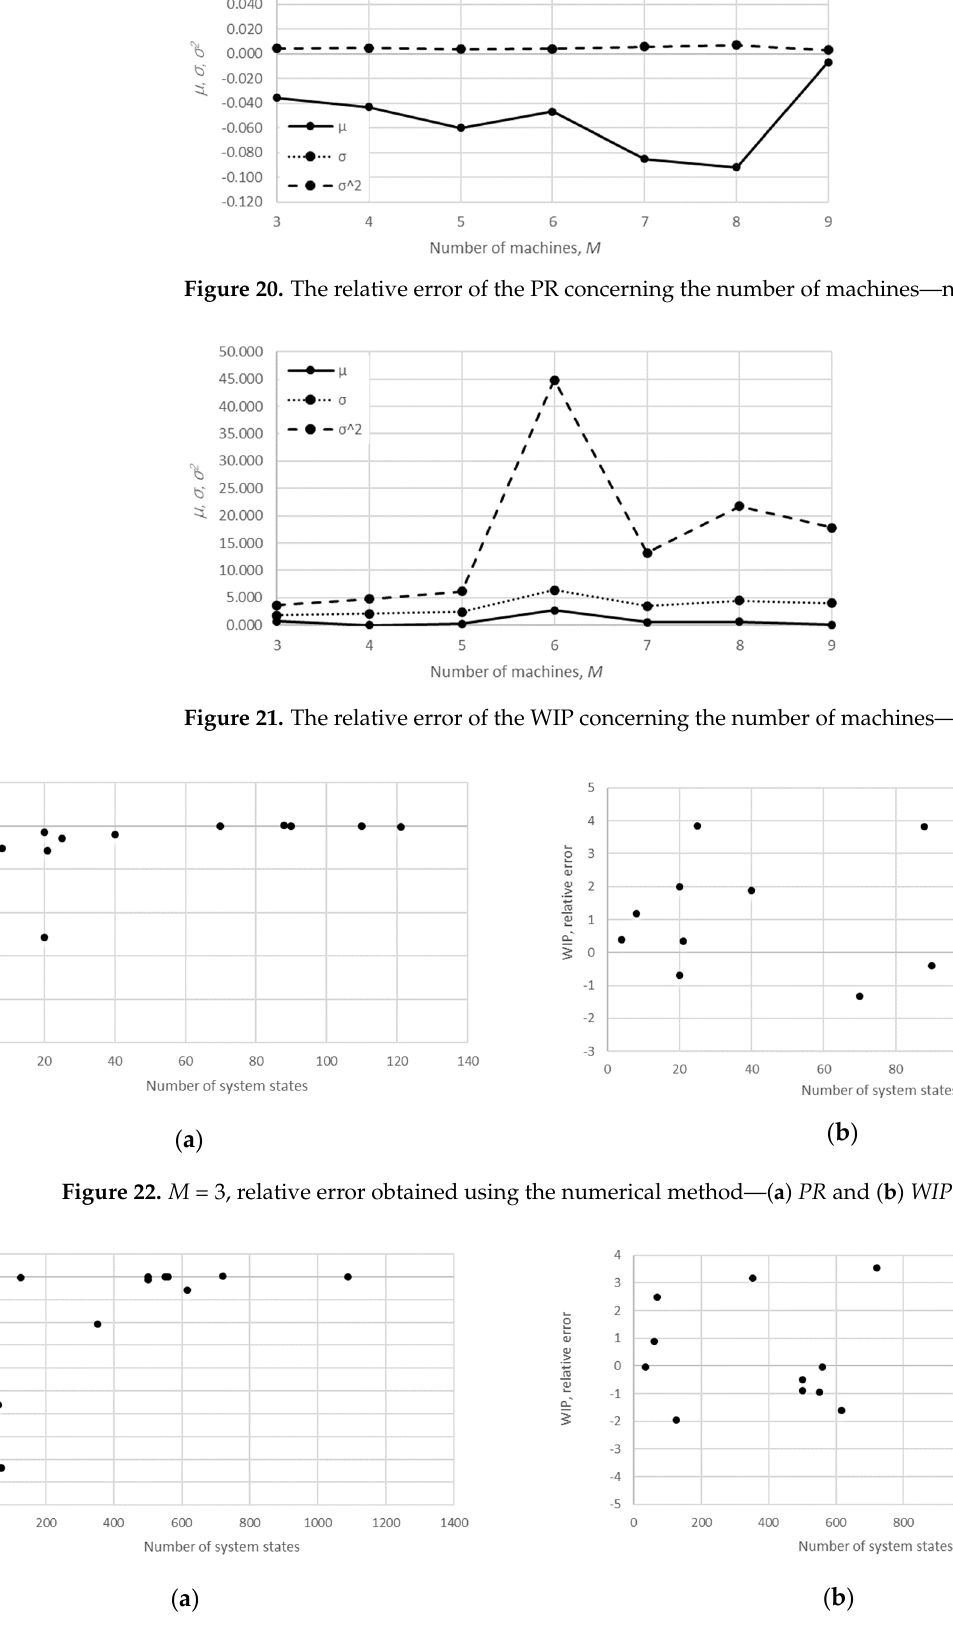
Figure 23. M = 4, relative error obtained using the numerical method—( a ) PR and ( b ) WIP